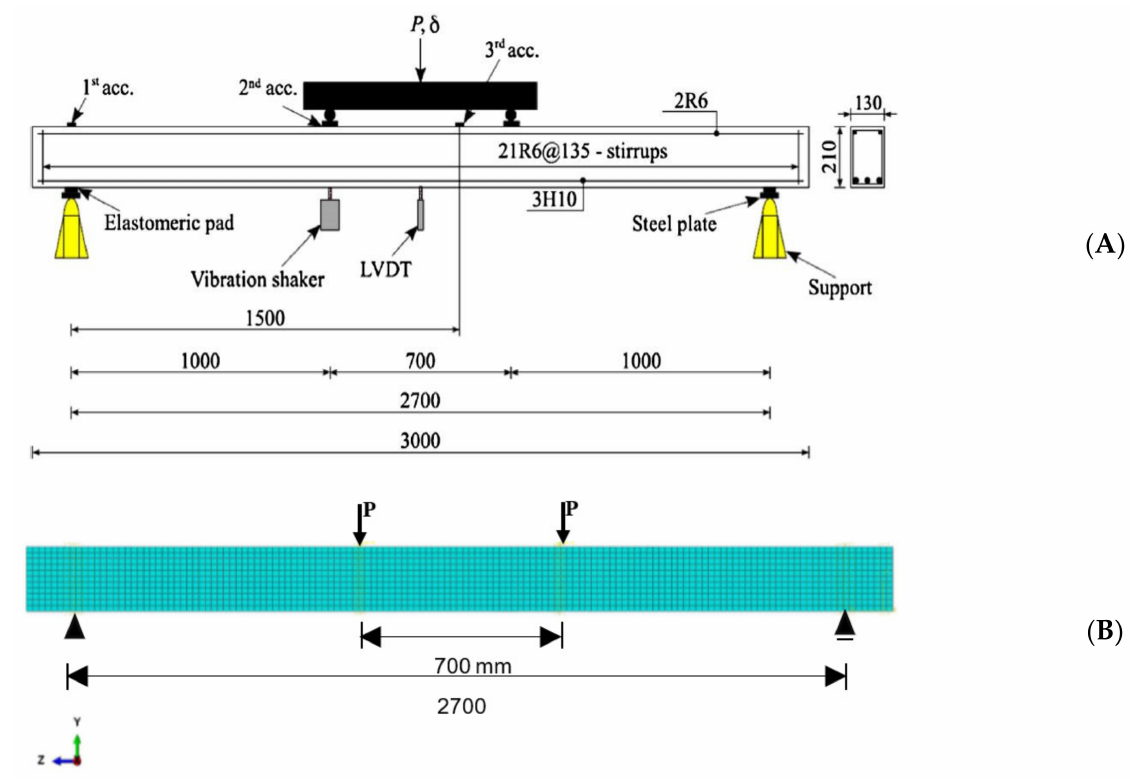
Figure 2. ( A ) Beam setup [28] reproduced with permission from Hanif M. U. ( B ) Current Studies Beam FEM simulation in ABAQUS and its